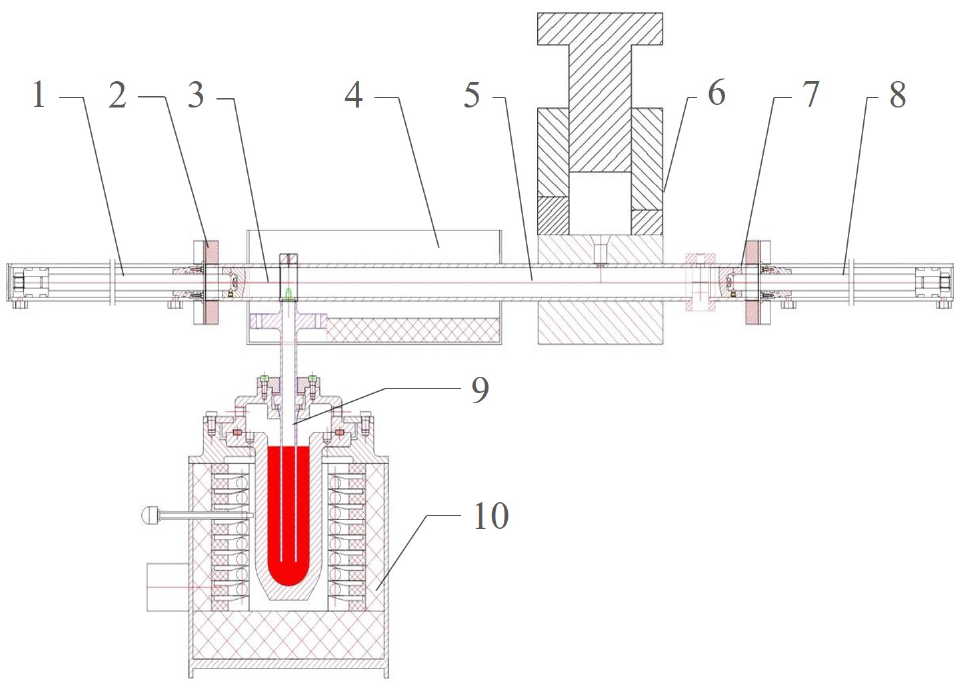
Figure 1. Quantitative feeding system device for squeeze casting forming.